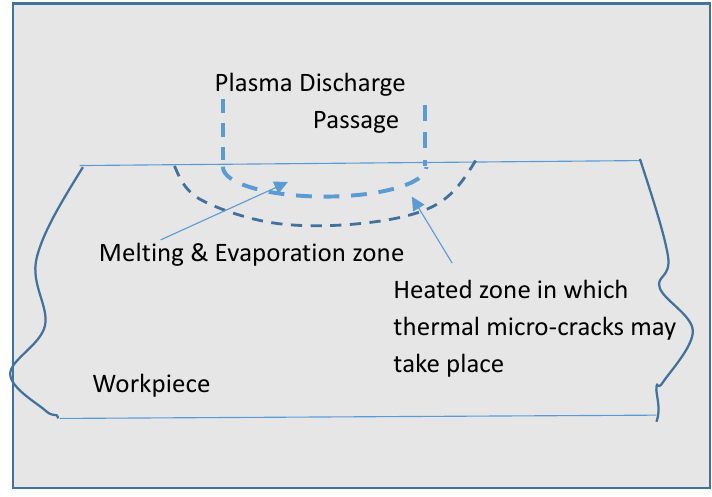
Figure 9. Thermal spalling effect on ceramic. (Reproduced with permission from [79]).